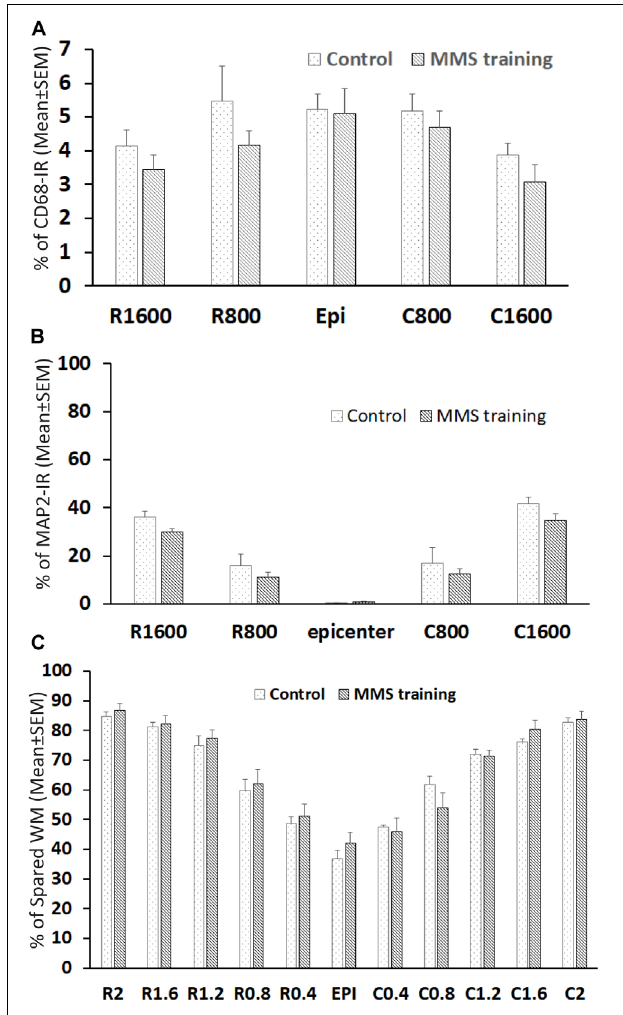
after Modified Montoya Staircase (MMS) rehabilitation. The neuroinflammation and spared gray matter were quantified with an immunohistochemical staining method using antibody against CD68 and MAP2, respectively. The spared white matters (WMs) were quantified using eriochrome cyanine (EC) staining. The quantification showed no significant difference between control and MMS rehabilitation groups in percentages of CD68-IR (A) , percentages of spared gray matters (B) , or percentages of WMs (C) . Results in (A–C) represent mean ± standard error of the mean (SEM); n = 5 in each